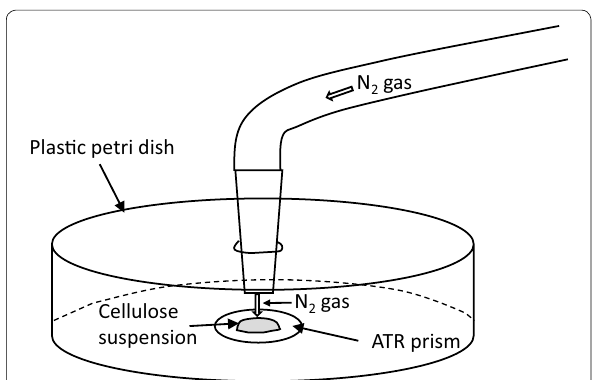
Fig. 1 Schematic representation of the apparatus used to acquire an infra-red spectrum in attenuated total reflection mode